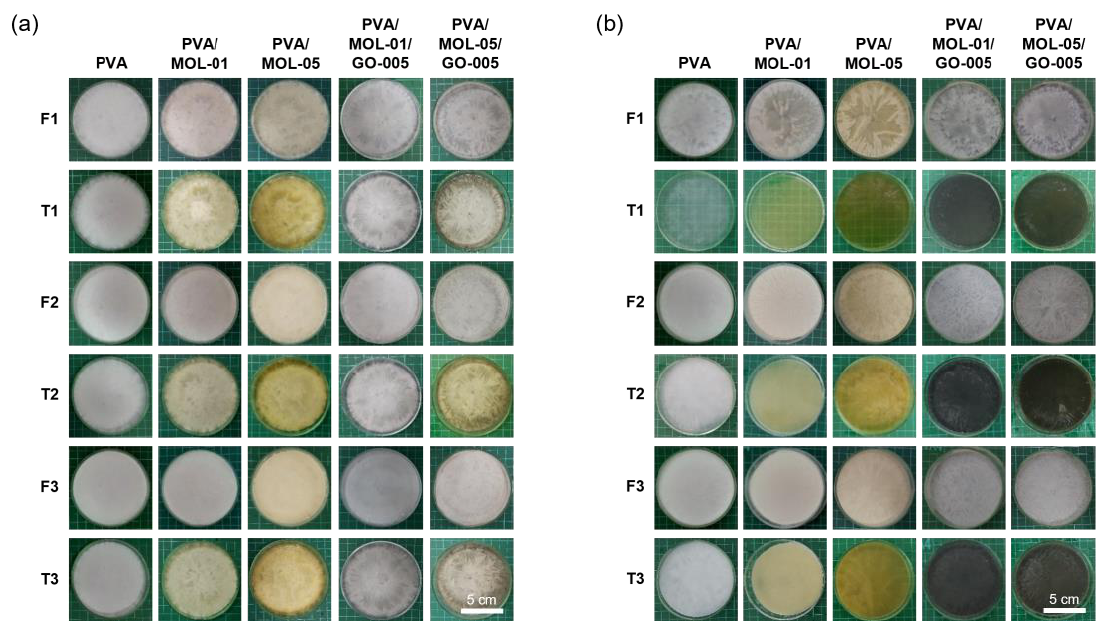
Figure 1. Physical appearances of hydrogels after each freezing and thawing cycle, indicated by F and T, respectively, ( a ) freezing at −20 °C and thawing at 5 °C and ( b ) freezing at − 20 °C and thawing at 25 °C.